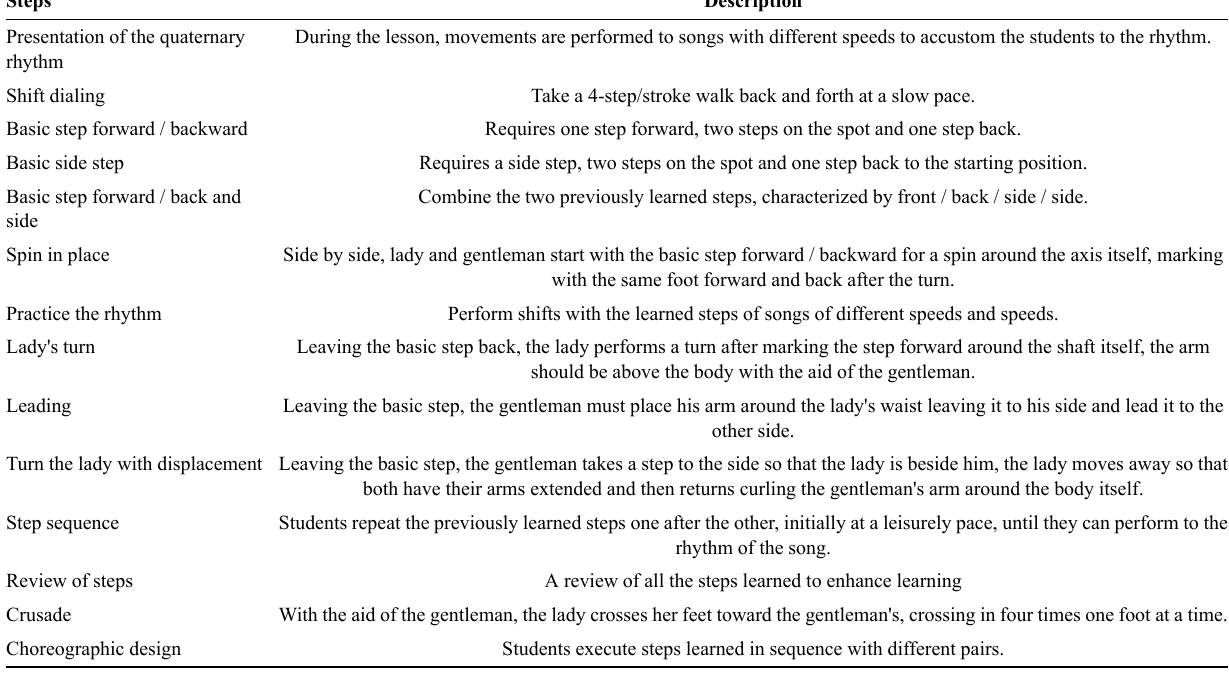
Table 2 - Description of the steps to be taught in the Quaternary group intervention. Steps